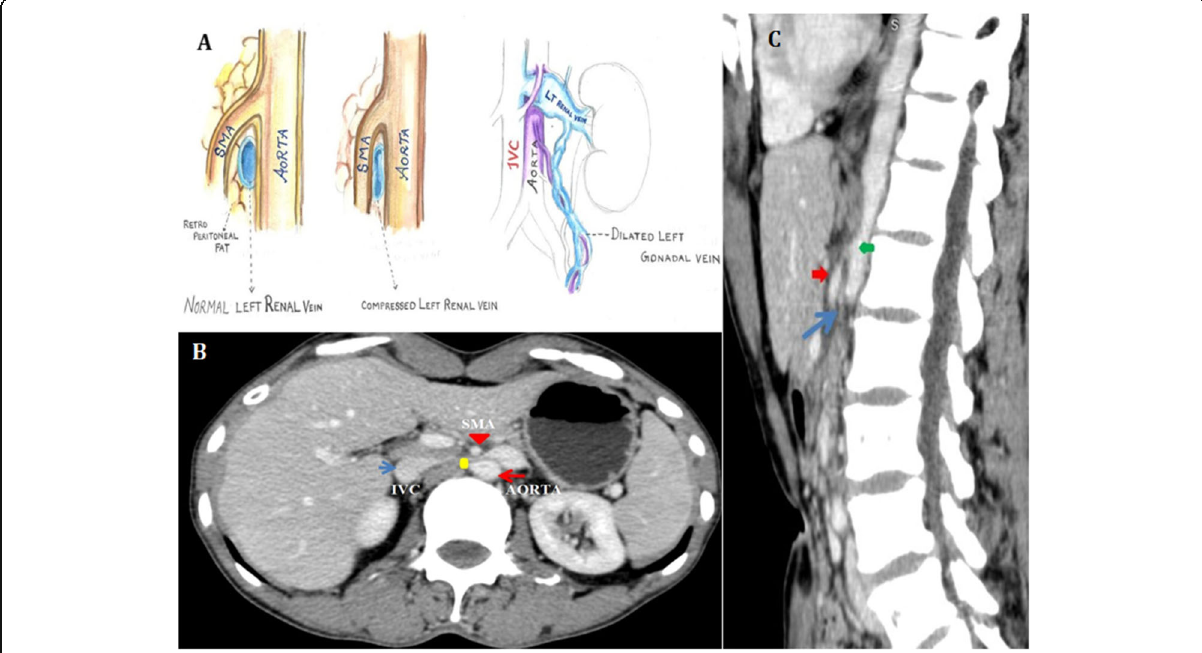
the abdomen in venous phase shows the left renal vein (dot) being compressed by the superior mesenteric artery (arrowhead) and the aorta (left arrow). Reformatted sagittal image ( c ) clearly depicts the compressed left renal vein between the SMA and the aorta. The left renal vein (long arrow) proximal to the compression is moderately dilated. The hand diagram is self-drawn by the